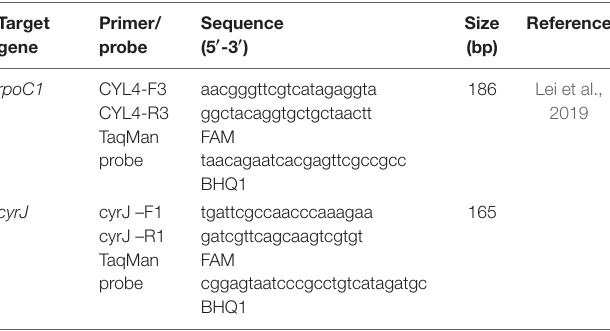
TABLE 1 | Primers and probes used for real-time